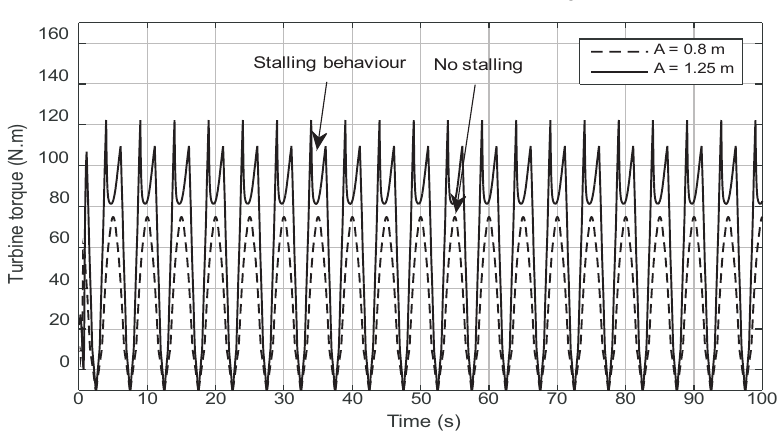
Figure 8. Flow coefficient vs. time for two wave magnitudes [22,23].